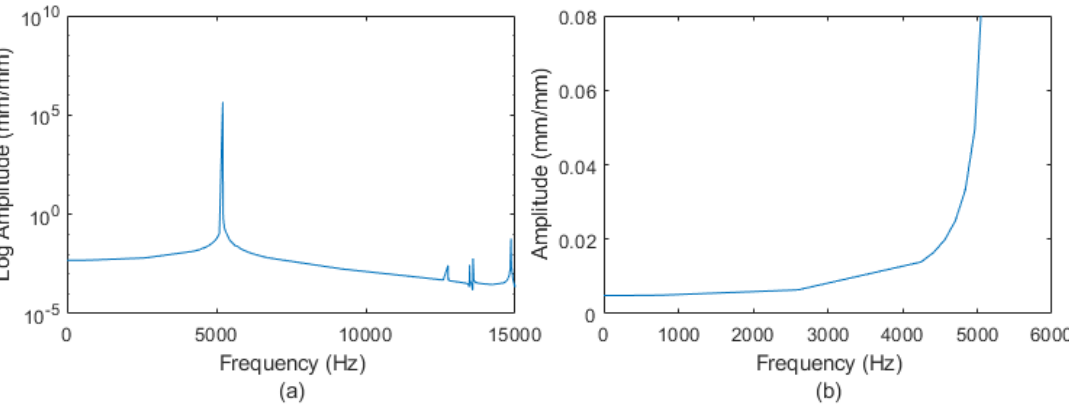
Figure 11. Harmonic response of the diagrams under the measuring of torque Mz: ( a ) Range 0-15000 Hz ( b ) Range 0-6000 Hz.